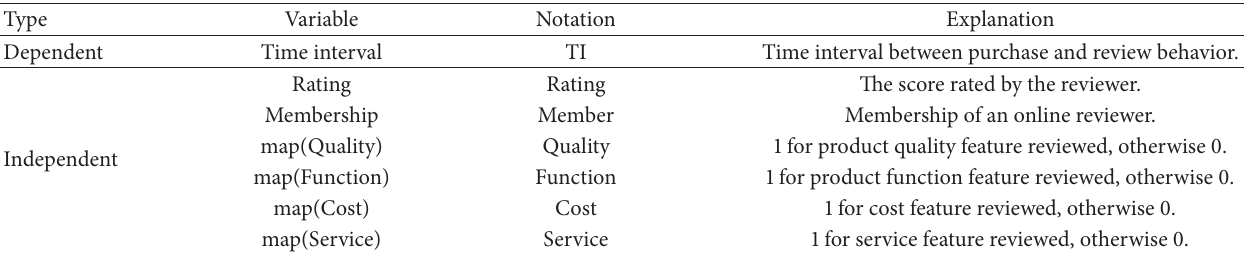
Table 6: Variables and explanations.